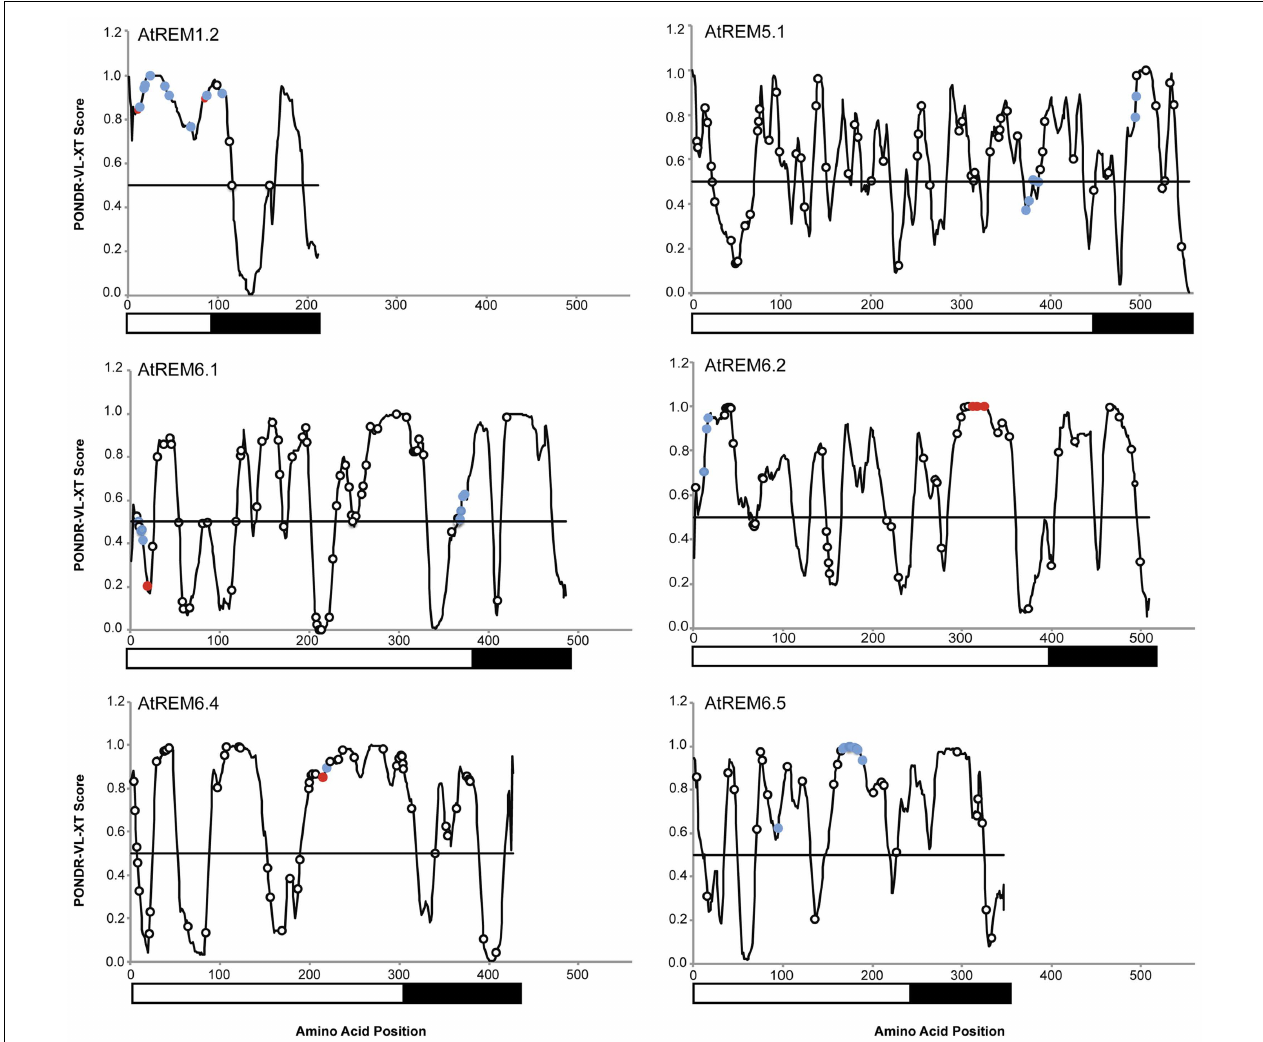
FIGURE 2 | Phosphorylation of serine and threonine residues clusters in intrinsic disordered regions. Blue circles represent sites mapped under control (non-stimulated) conditions. Red circles represent sites mapped upon application of MAMPs. Black and white boxes under the plots indicate